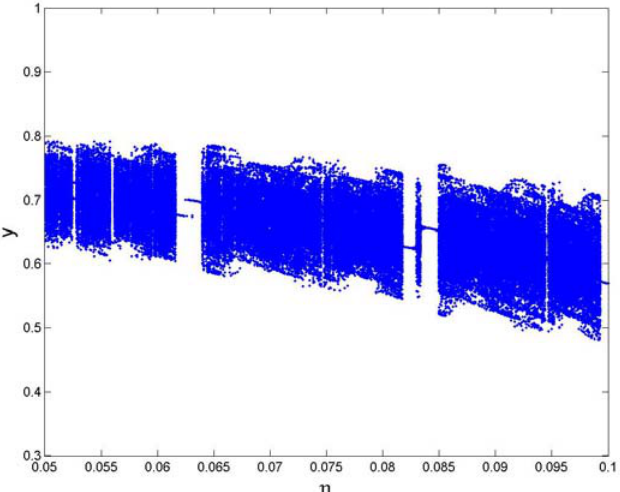
Figure 9. Bifurcation diagram of the squeeze film damping ratio 